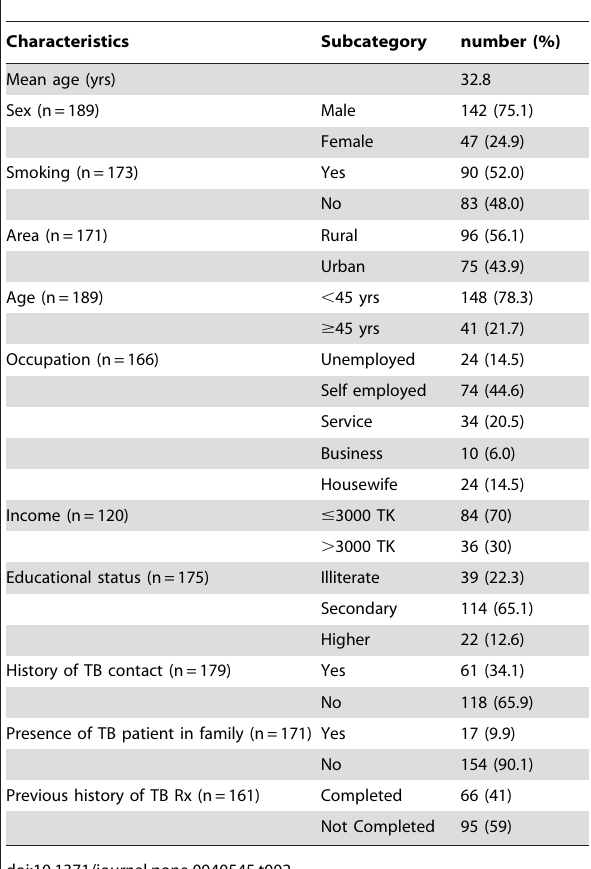
Table 2. Socio demographic characteristics of TB patients.